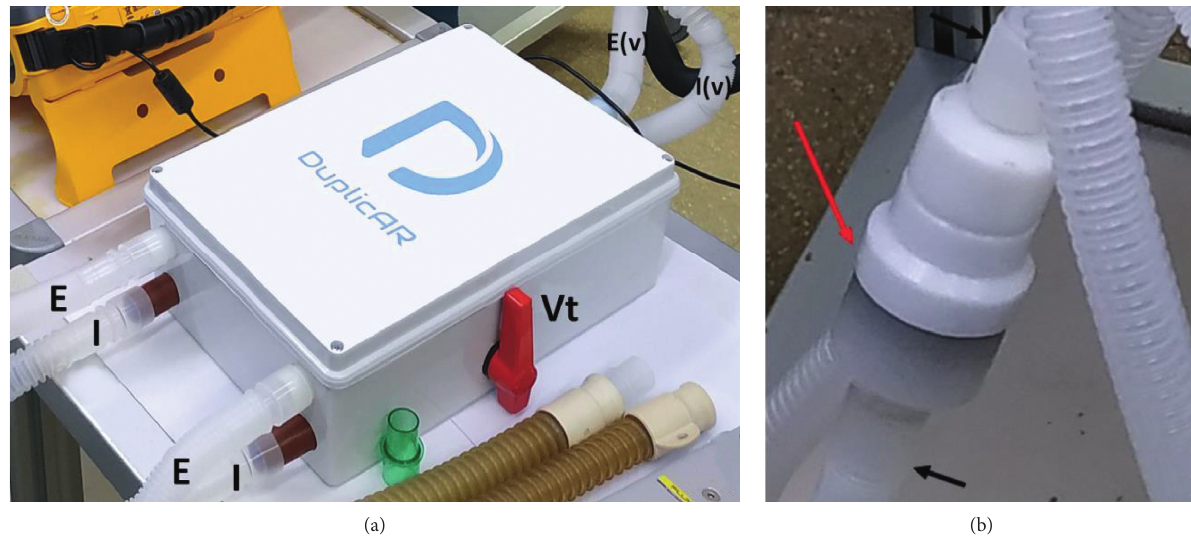
Figure 1: The DuplicAR Ⓡ device: (a) the device with its connections; (b) the PEEP valve controller. E, expiratory limb of each subject; E(v), expiratory limb connected to the ventilator; I, inspiratory limb of each subject; I(v), inspiratory limb connected to the ventilator; Vt, tidal volume/peak-pressure controller; red arrow, PEEP controller; black arrows, expiratory